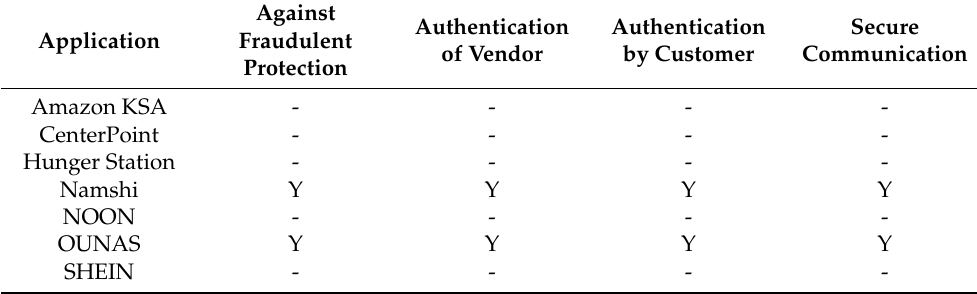
Table 9. Customer rating